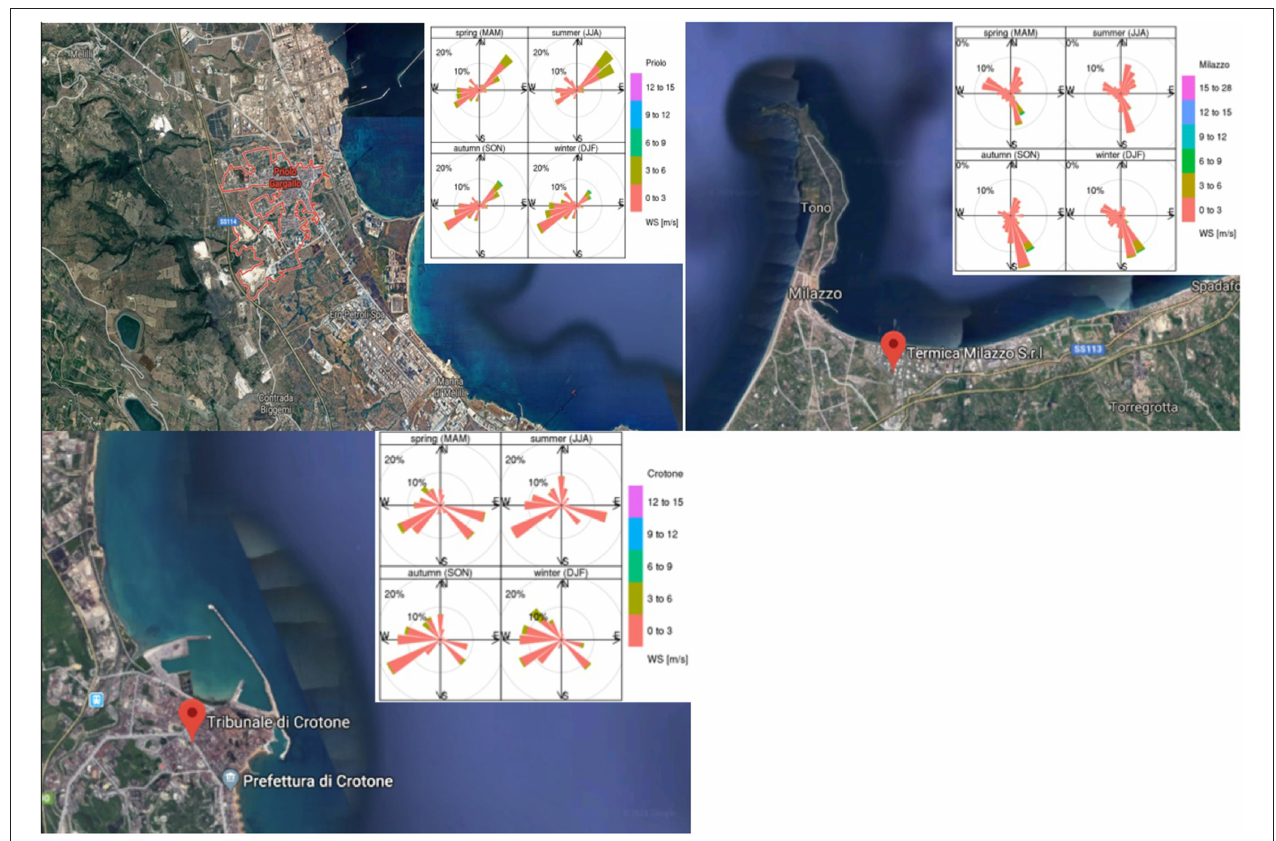
FIGURE 3 | Wind roses of observed seasonal wind speed and direction are shown for Priolo (upper panel), Milazzo (middle panel), and Crotone (lower panel). The integration period ranges between January 2016 and December 2018. The colorbar indicates the wind speed [m/s], keeping in mind that 5 m/s is the max wind intensity for wind breeze regimes. The concentric circumferences represent the occurrence (%) of wind direction calculated over all period (maps were generated by superimposing the wind roses and the google map - https://www.google.it/maps - screenshots of the regions of